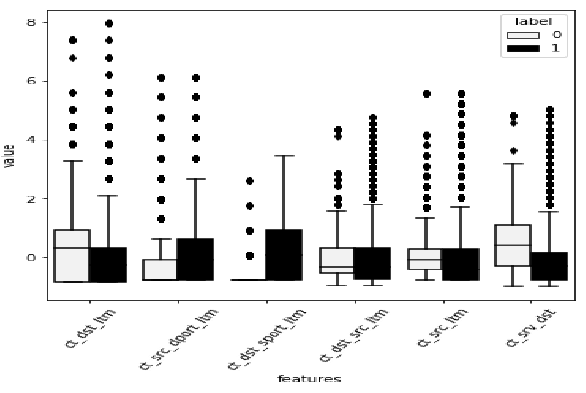
Fig 2. Box and whisker plot for six significant features of the